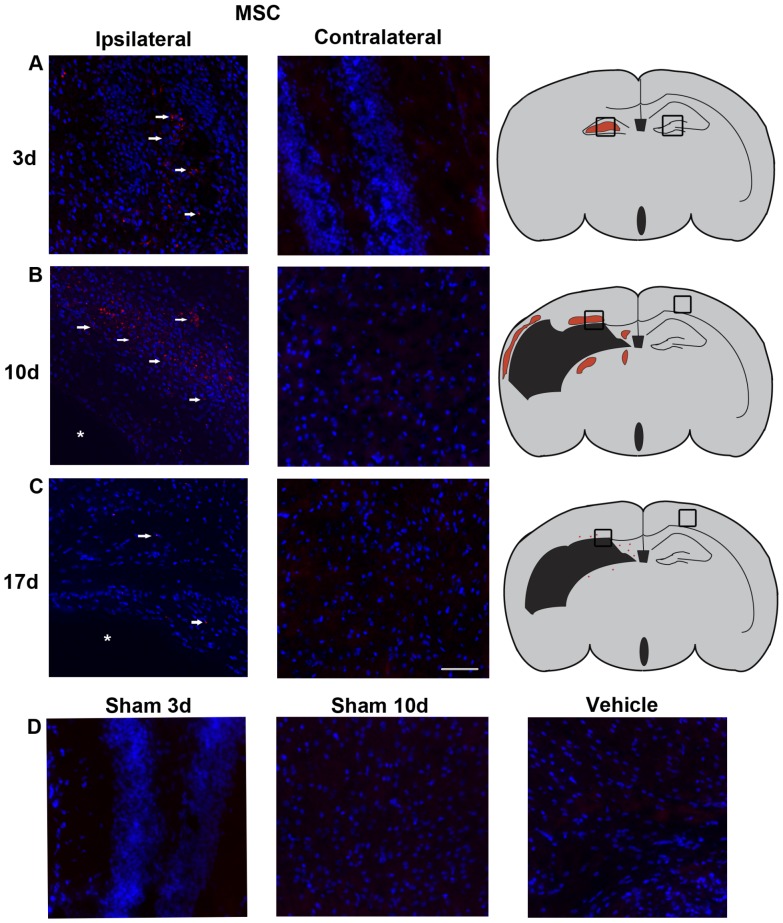
Presence of MSCs in the brain.PKH-26 labeled 1.0×106 MSCs were administered intranasally at 3, 10 and 17 days post-HI. Because no significant difference was found between Veh groups treated at different time points we pooled all animals into one group. (A, B, C) Notice the severe HI-induced damage, as the layer structure of the ipsilateral cortex and hippocampus are lost. (A) MSCs (red) in the ipsilateral hippocampus (see arrow heads) 24 h after administration at 3 days post-HI. (B) MSCs (see arrow heads) in the ipsilateral damaged cortex 24 h after administration at 10 days post-HI. (C) Lack of MSCs (see arrow heads) in the ipsilateral cortical areas surrounding the lesion site when MSCs are given at 17 days post-HI. Contralateral pictures depict hippocampal area (in A) and cortical area (in B and C). (D) Control groups showing lack of MSCs in the hippocampal area and cortical area at 3 and 10 days, respectively, after MSC administration in sham-operated animals and HI-Vehicle treated brain without MSC treatment. Asterisk = lesion site. Blue = Dapi staining. Scale bar 50 µm. Data presented in this figure are results from pooled experiments out of 10 different litters. Treatment groups were randomly distributed between litters.